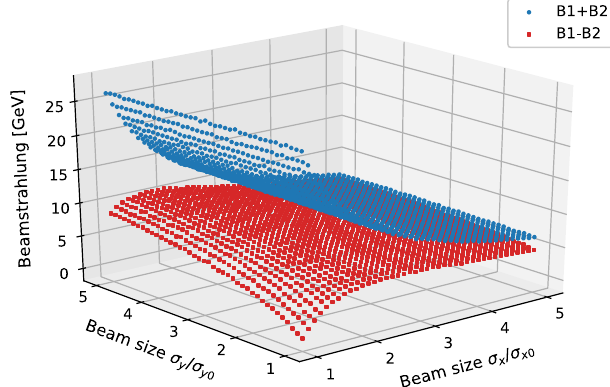
FIG. 2. Simulation of the emitted beamstrahlung during a head-on collision between a nominal beam (beam 2) and a nominal beam with scaled transverse beam sizes (beam 1).